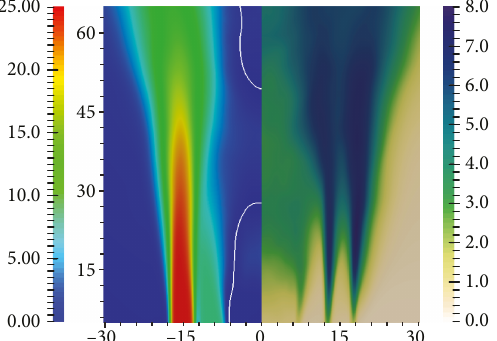
Figure 4: Mean ( r < 0mm ) and rms ( r > 0 mm ) velocity behind the blu ff